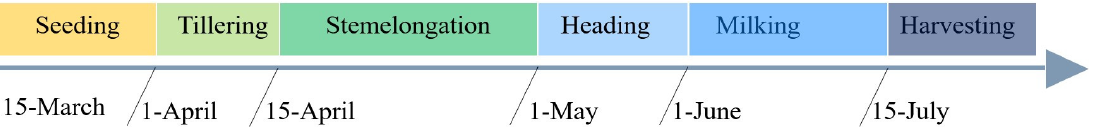
Figure 3. Early paddy rice phenology in Shazai Island.